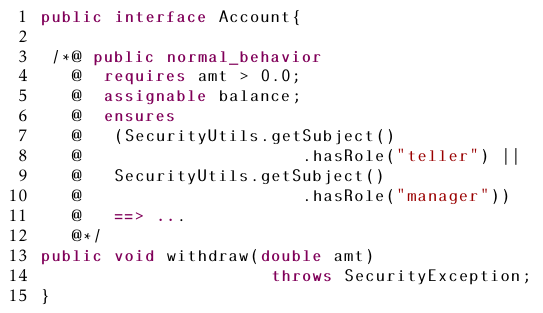
Figure 15. Specification Stubs forthe ApacheShiro API.